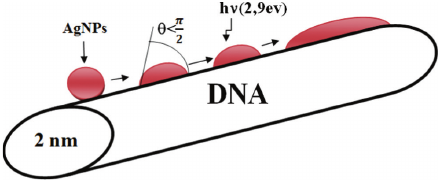
Figure 9 Model of DNA moisturizing by silver nanoparticles.